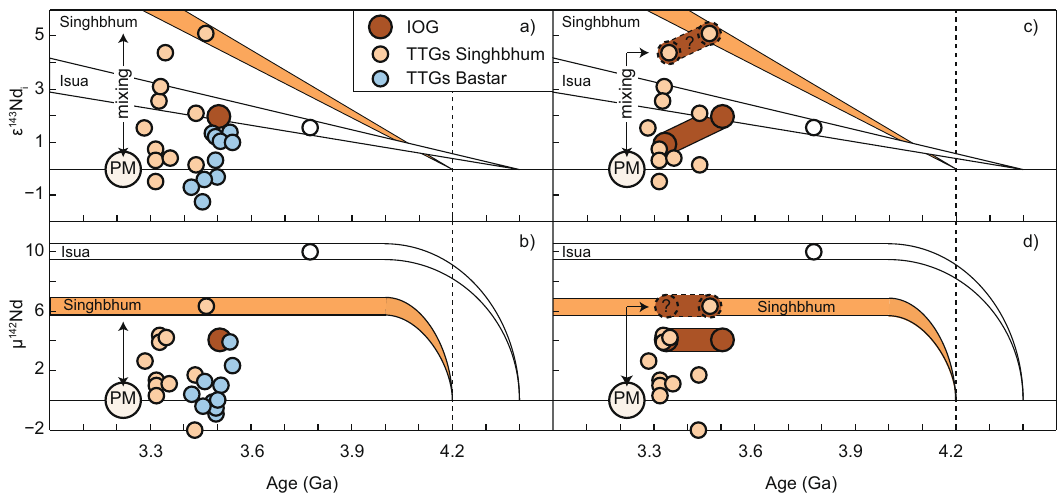
Fig. 2 147 Sm – 143 Nd and 146 Sm – 142 Nd isotope evolution of the Singhbhum mantle source and petrogenesis. The tiles illustrate two possible petrogenetic scenarios for the formation of ma fi c rocks from the IOG greenstone belt and TTGs from the Singhbhum Craton. Panels a and b consider only the isotope composition of the source melts such that the vertical spread de fi ned by TTGs in Nd isotope vs. time space re fl ects mixing of melts derived from both depleted and primitive mantle (PM) domains. Panels c and d also consider the petrogenesis of TTGs which were likely produced by re-melting of a ma fi c protolith, here represented by the 3.51 Ga supracrustal rocks from the eastern IOG belt. In this scenario, the most radiogenic Nd isotope compositions require a so-far elusive ma fi c precursor extracted from the depleted mantle shortly before formation of the granitoids. The distinct evolution of the Isua depleted mantle reservoir is shown for